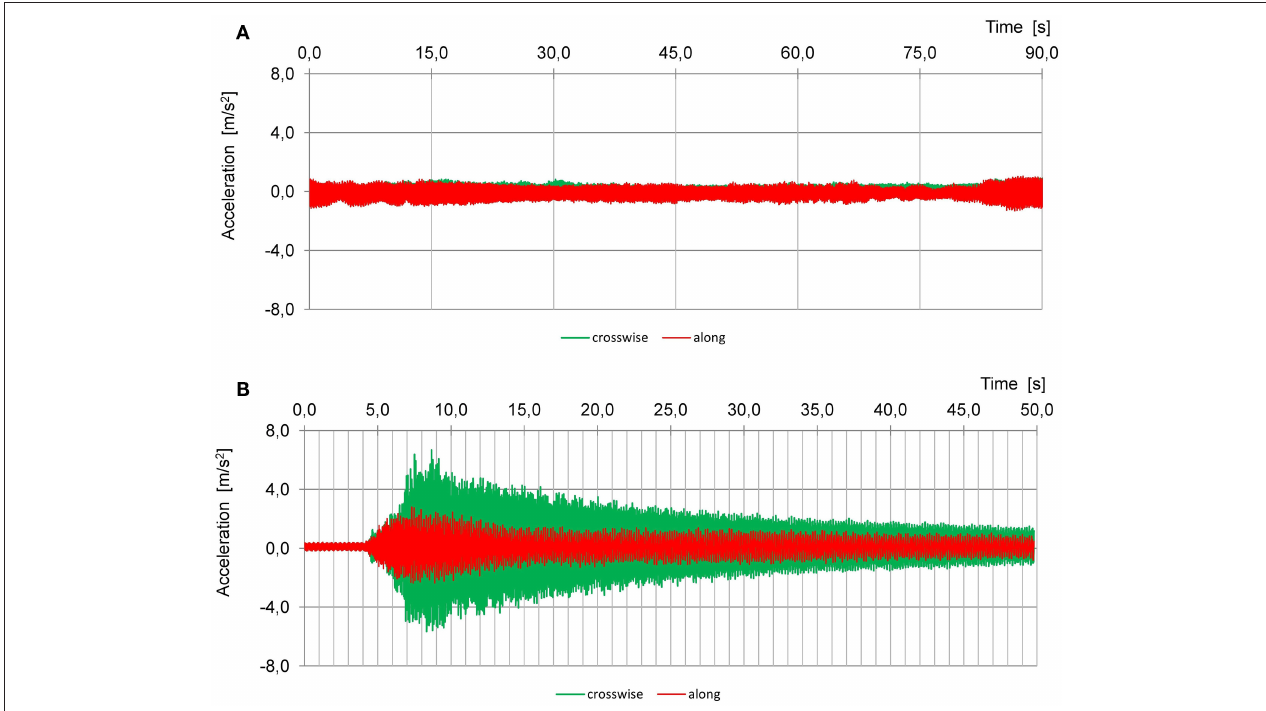
FIGURE 13 | Measured time-histories of the horizontal accelerations of hangers for passage of a special train (two locomotives and four passenger railcars placed between them): (A) at the speed v = 10km/h, (B) at the speed v = 200km/h; the directions of horizontal accelerations: crosswise and along are given relative to the track